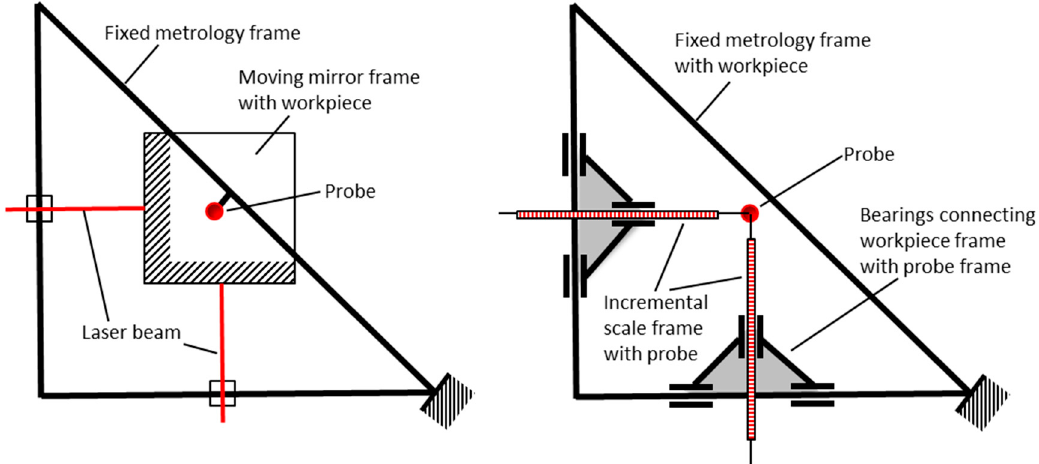
Figure 2. Principle of measurement stages (2D case for simplification of drawing). ( left ) Laser interferometer scales and moving workpiece stage with reference mirror frame; ( right ) Incremental scales and moving probe stage with additional bearings between frames.